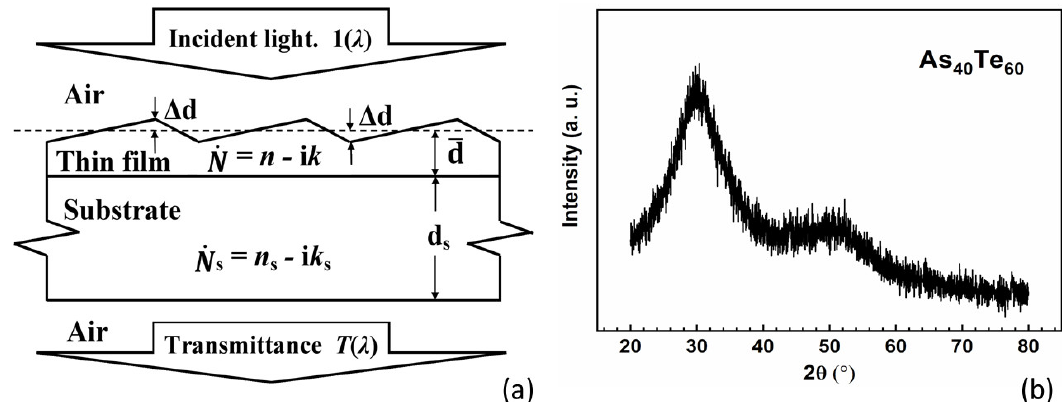
Figure 1. ( a ) A sketch of a homogeneous thin film on a substrate specimen, and its main optical characteristics [29]. ( b ) X-ray diffraction (XRD) image for a plasma deposited As 40 Te 60 film on a glass substrate.